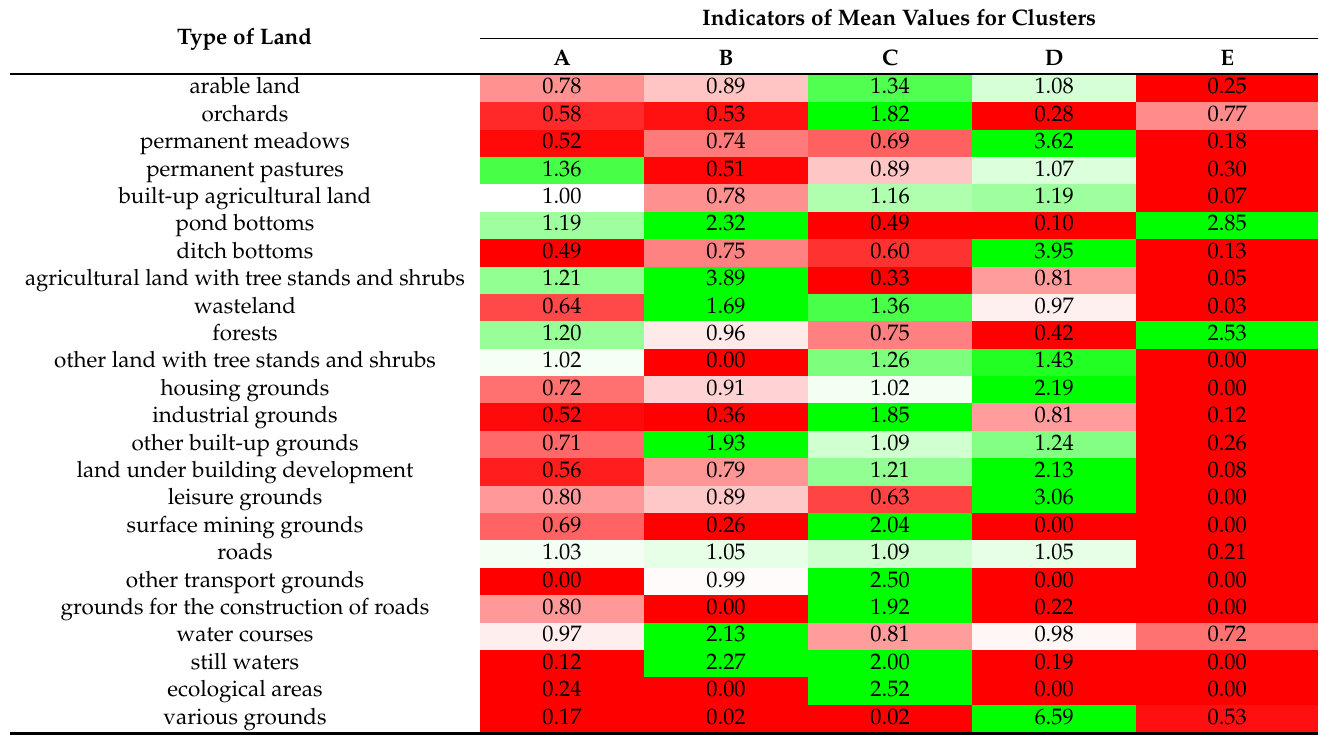
Table 5. Values of indicators for identified